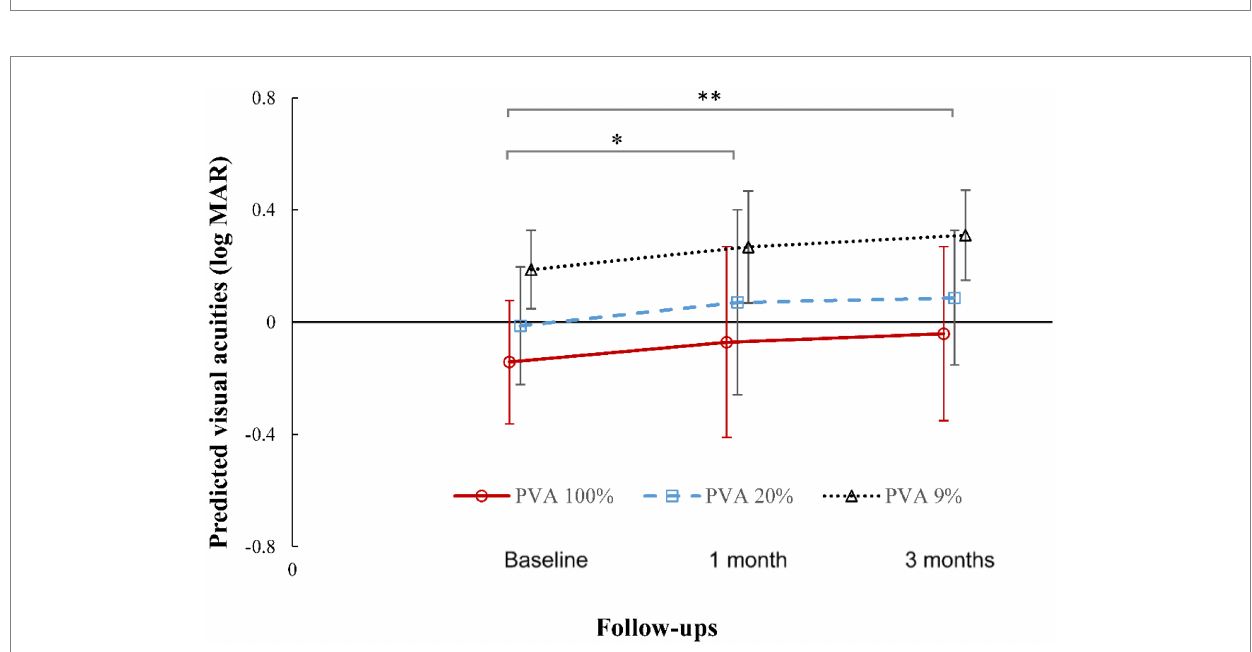
FIGURE 2 Changes in optical quality parameters after wearing orthokeratology lenses for 3 months. Error bars represent the standard deviation. ***, p < 0.001; **, p < 0.01 and *, p < 0.05, according to post hoc Bonferroni tests. (A) reprensents the modulation transfer function cut off frequency. (B) reprensents strehl ratio. (C) reprensents the objective scattering